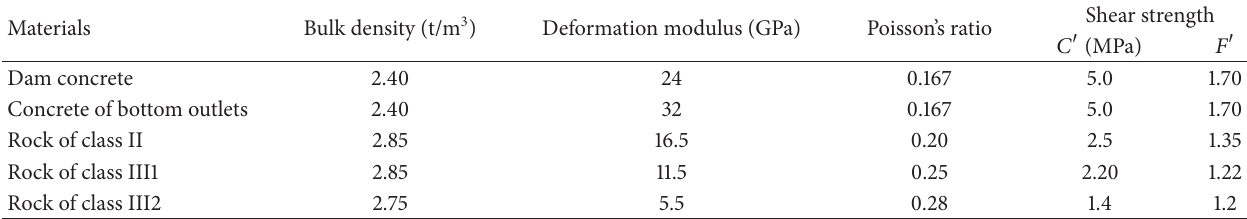
Table 3: Physical-mechanical parameters of the rock masses and dam materials.